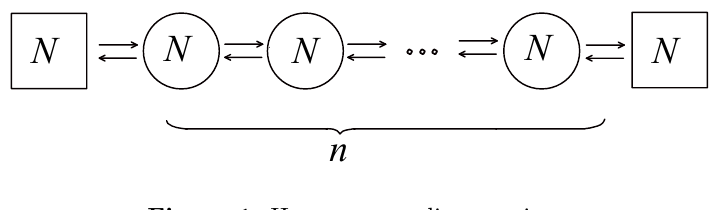
Figure 1 . Homogeneous linear